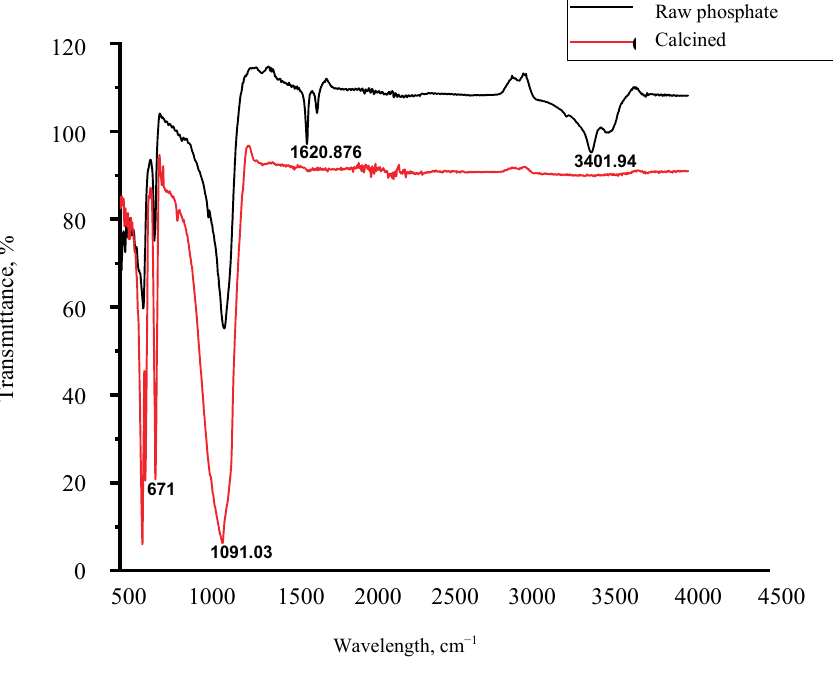
Fig. 3. FTIR spectrum of the uncalcined and calcined phosphate